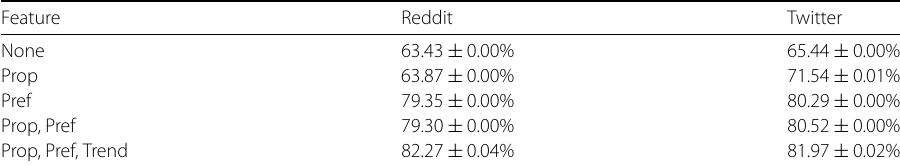
Table 4 Effect of author property and topic trend on the prediction accuracy. We examined three features: the user-dependent propensity to continue any topic (“Prop”), the preference to topics (“Pref”), and the topic trend due to news and social events (“Trend”). The mean and the 99% confidence interval are shown Feature Reddit